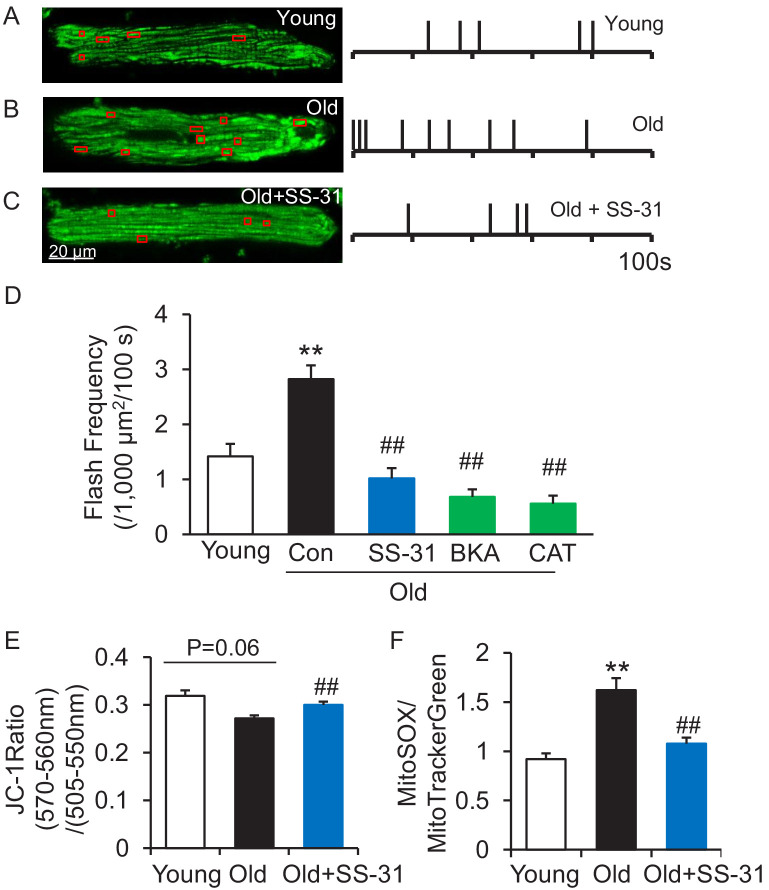
SS-31 attenuates excessive mitoflash activity in aged rat cardiomyocytes.(A–C) Mitoflash events within the regions shown in the red boxes took place at the times shown by vertical bars during the 100 s scanning time in the representative cardiomyocytes from young (A), old (B) and old+SS-31 (C) rat hearts. (D) The rate of mitoflash activity was increased in old rat cardiomyocytes compared to young, but 1 hr SS-31, Bongkrekic Acid (BKA) (10 μM) and Carboxyatractyloside (CAT) (20 μM) treatments decreased the mitoflash frequency in old cells to or below that of young cells. N = 26–87 cells from 3 to 14 rats. **p<0.05 vs young. ##p<0.05 vs old. (E) JC-1 red to green fluorescence ratio, indicative of mitochondrial membrane potential, in cells from young and old mice and old mouse cardiomyocytes treated with SS-31 (10 μM for 12 hr). N = 84–218 cells from 3 to 4 mice. p=0.06 vs young. ##p<0.01 vs old. (F) Mitochondrial ROS production in mouse cardiomyocytes measured by the fluorescence ratio of MitoSOX (5 μM, excitation 540 nm, emission >560 nm) to Mitotracker green (200 nM, excitation 488 nm, emission 505–530 nm). One-way ANOVA with Dunnett’s test was applied. N = 40–84 cells from 3 to 5 mice. **p<0.05 vs young. ##p<0.05 vs old.